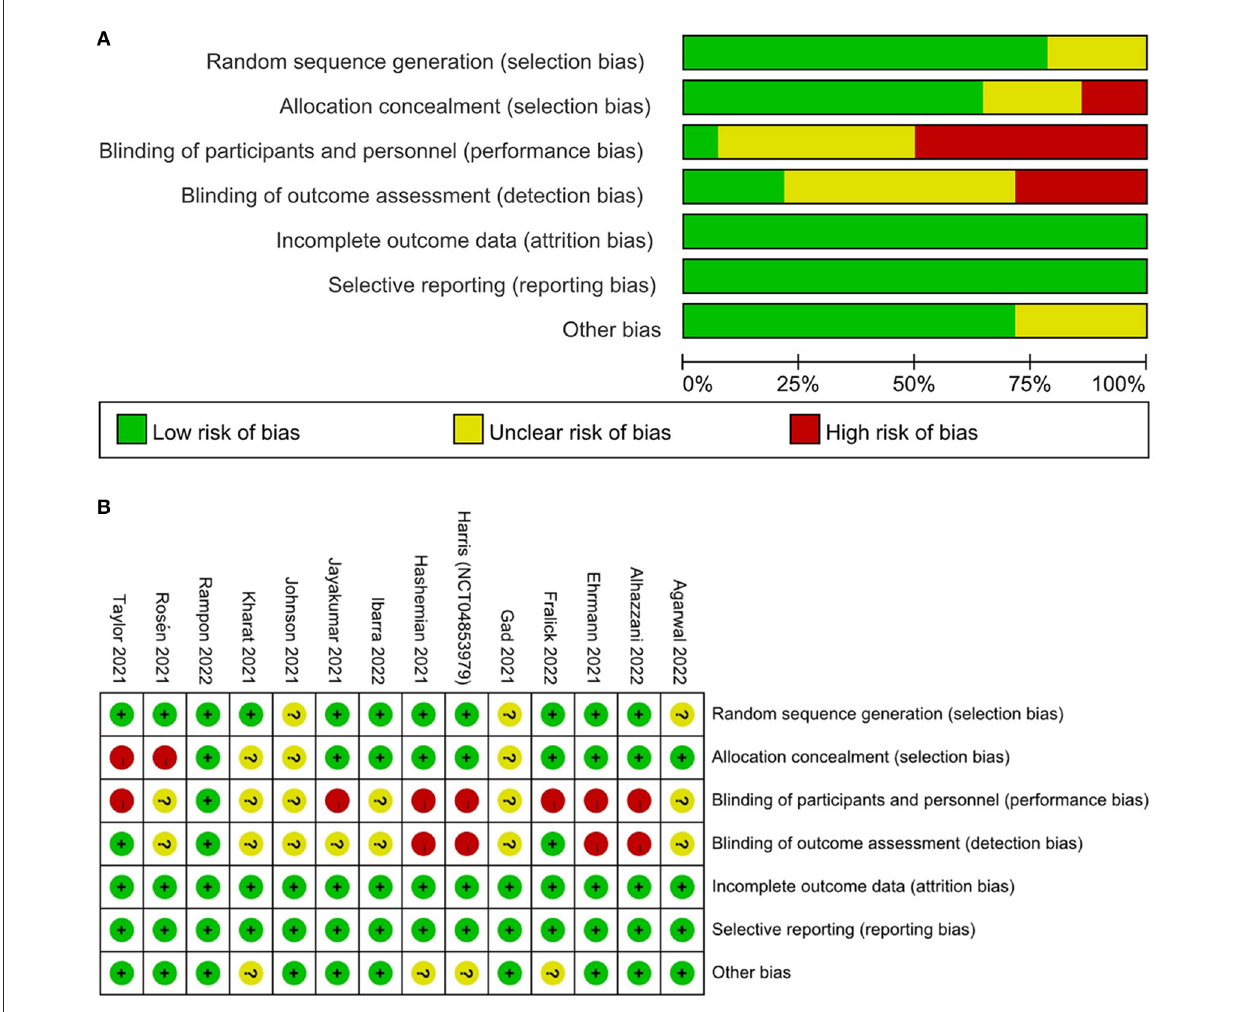
FIGURE2 Assessment of risk of bias based on the Cochrane risk of bias tool. (A) Risk of bias graph; (B) Risk of bias summary.